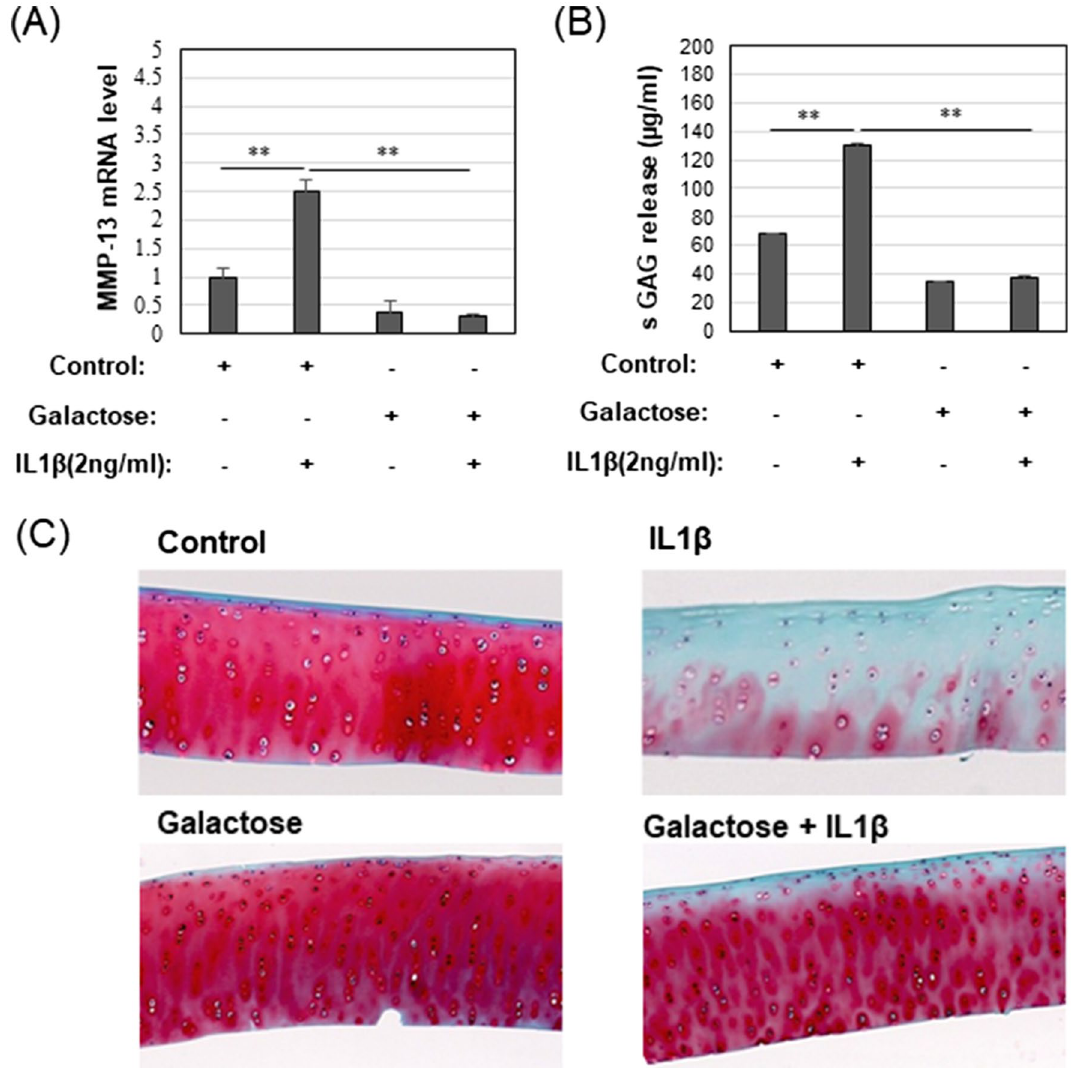
Figure 6. Galactose-replaced culture conditions block pro-catabolic features of activated chondrocytes and cartilage. ( A ) Expression of MMP13 mRNA of by bovine chondrocytes treated with or without IL1β in Control glucose or galactose culture medium [untreated control value set = 1.0; mean ± S.D. (error bars), n = 3]. ( B ) Quantified sulfated glycosaminoglycan released or lost from the tissue and accumulated in the medium by a colorimetric: Dimethyl-Methylene Blue (DMMB) assay (after 3 days) of bovine explant cultures [mean ± S.D. (error bars), n = 4]. ( C ) Representative images of bovine cartilage sections stained by Safranin O and Fast Green from explant cultures treated with or without 3 ng/ml IL1β in Control glucose or galactose culture medium for 7 days (n = 4). ANOVA followed by Tukey post-hoc test was used for statistical analysis. *p < 0.05; **p < 0.01 . Another three representative images of bovine cartilage sections were shown in Supplementary Fig.